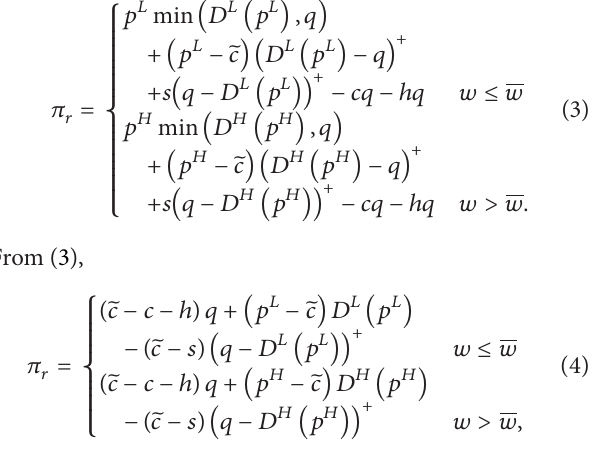
Figure 1: Demand corresponding to the two temperature states.